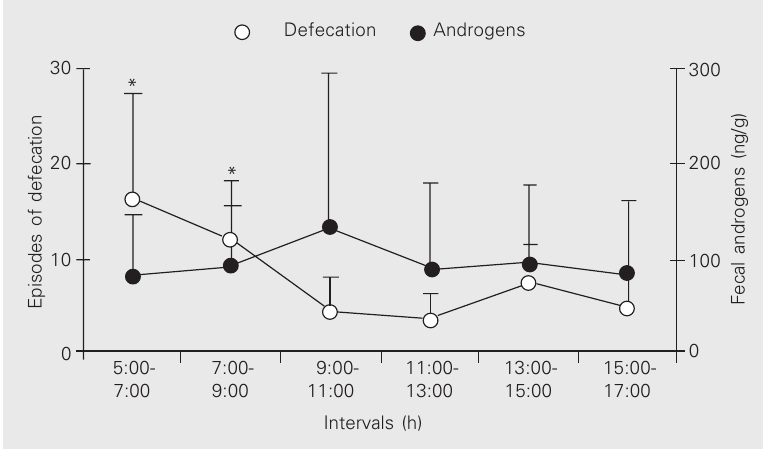
Figure 1. Mean defecation frequency in the six 2-h intervals during the natural light phase of the 24-h cycle for common marmoset males living in family groups in outdoor cages (open circles). Mean fecal androgens under the same conditions are given as filled circles. Data are reported as means ± SEM for 12 marmoset males. *The 5:00-7:00 and 7:00-9:00 intervals were significantly different from the others (P < 0.001,